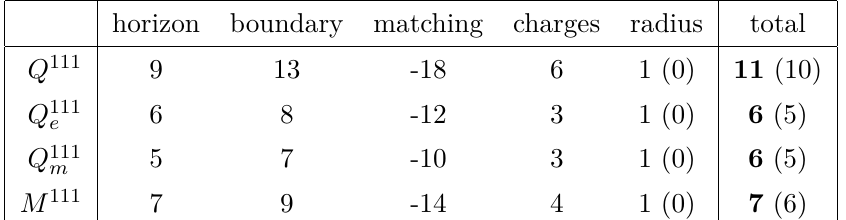
Table 2 . Counting the number of free parameters in each model, using the degrees of freedom in table 1 and the charges. The radius of the black hole is a free parameter for spherical black holes and hyperbolic black branes. For planar black branes, there is a symmetry 3 that effectively removes this degree of freedom, reducing the dimensionality of the solution space as indicated in